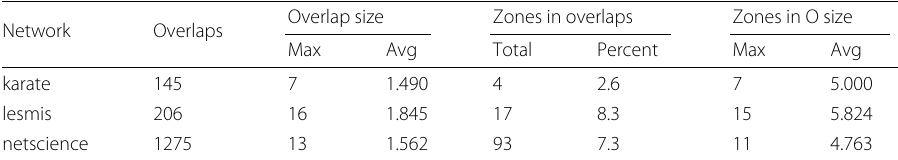
Table 5 Properties of zone overlaps in small